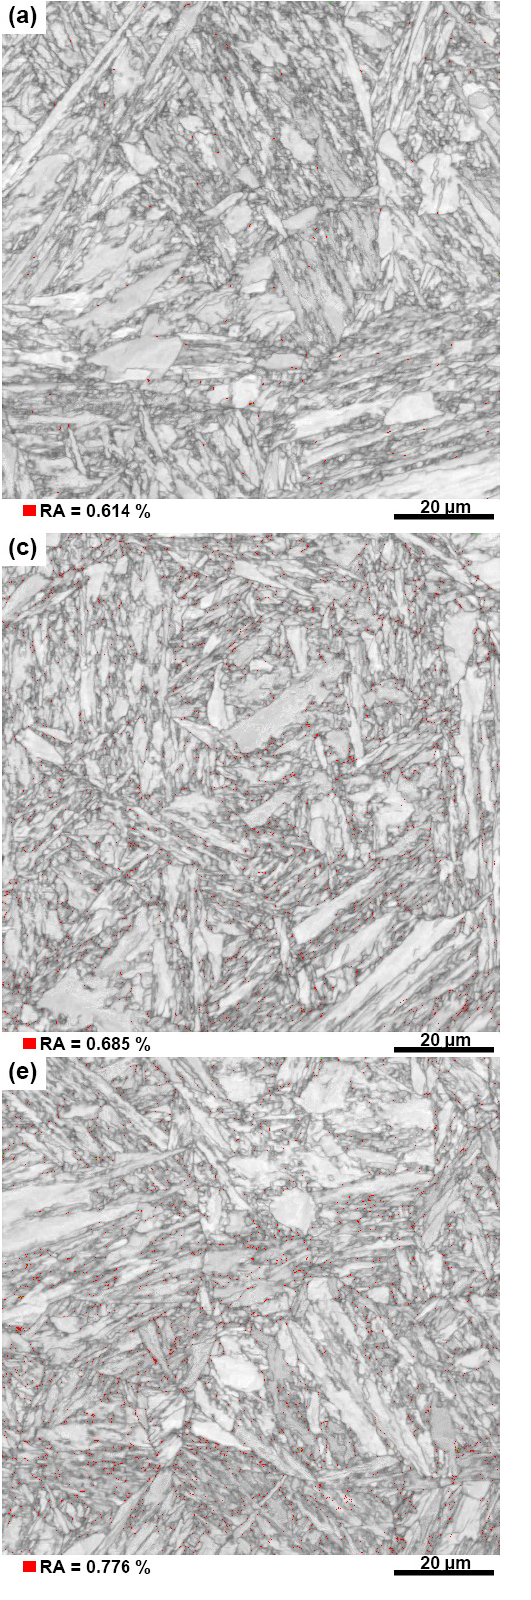
Figure 12. Phases distribution and BC values mixed with Gaussian fitted curves of samples under different treatments: ( a , b ) 1300 °C, t 8/5 = 20 s; ( c , d ) 1250 °C, t 8/5 = 20 s; ( e , f ) 1200 °C, t 8/5 = 20 s.